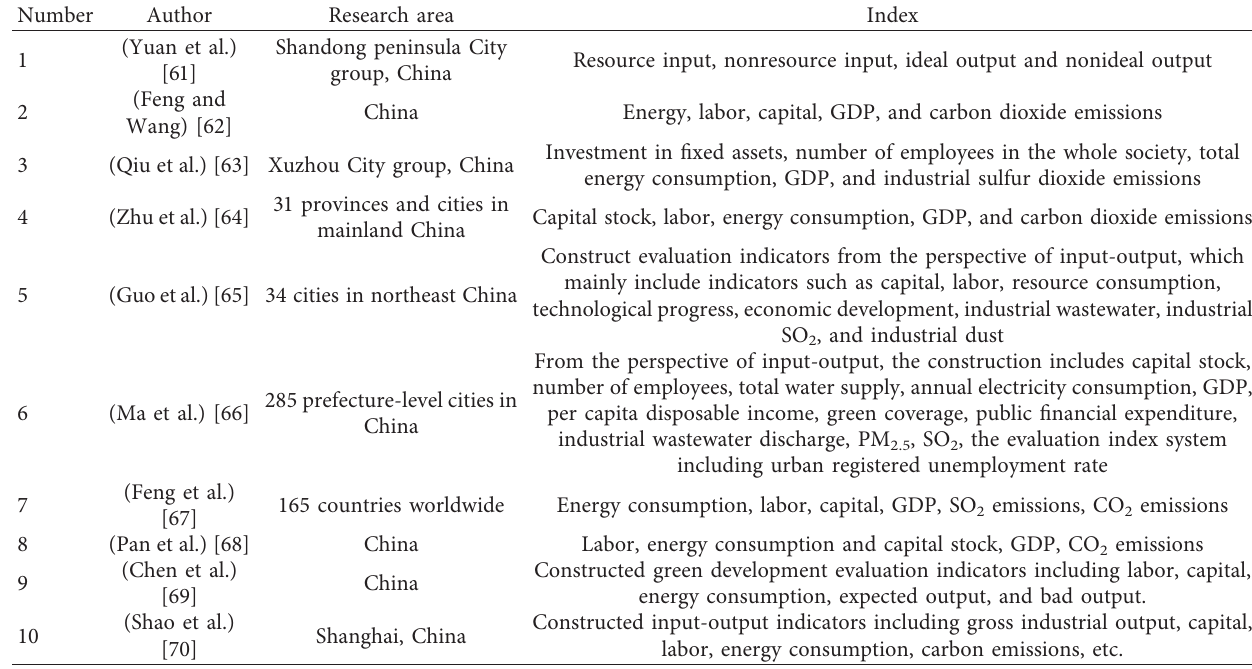
Table 1: Research on evaluation index system of green development